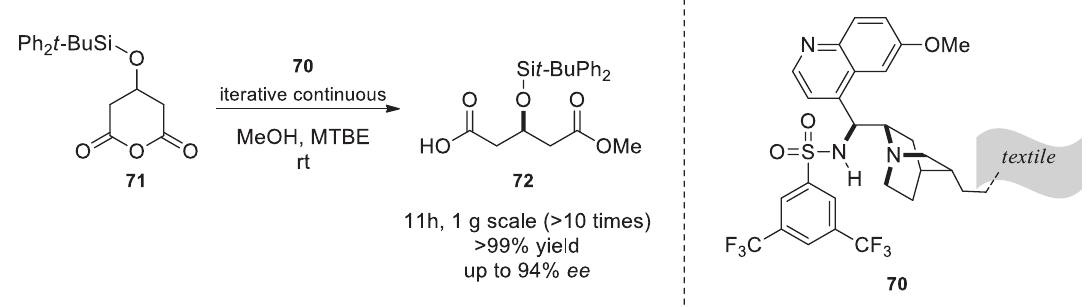
Figure 18 . “ OrganoTexCat ” for the desymmetrisation of sylilated glutamic anhydride, from Refs. [89, 90]. The reaction is performed under continuous conditions, in a fl ow reactor packed with 70.